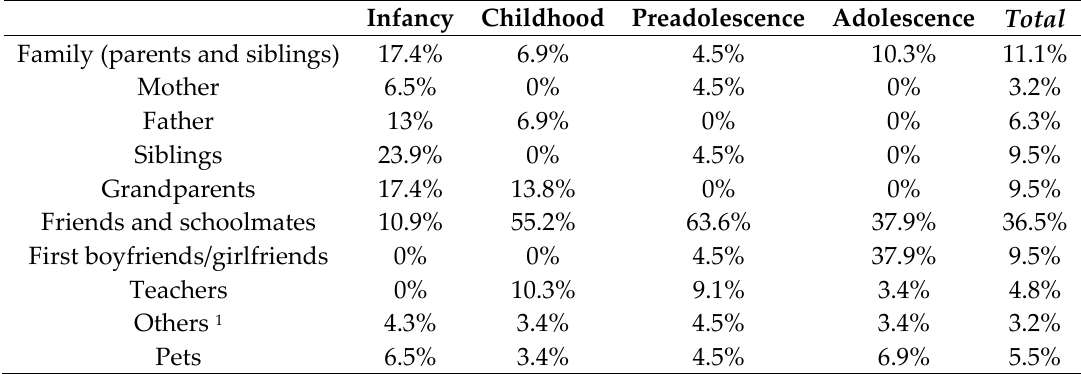
Table 4. Marker “Social References”: percentages on the total number of the drawings assigned to this indicator